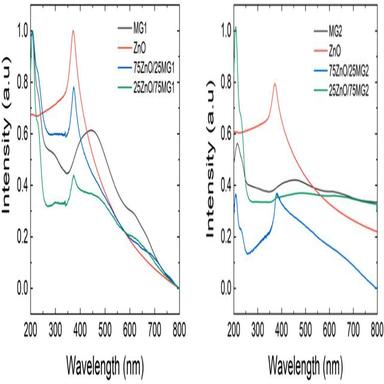
UV–VIS absorption spectra of the synthesized materials.